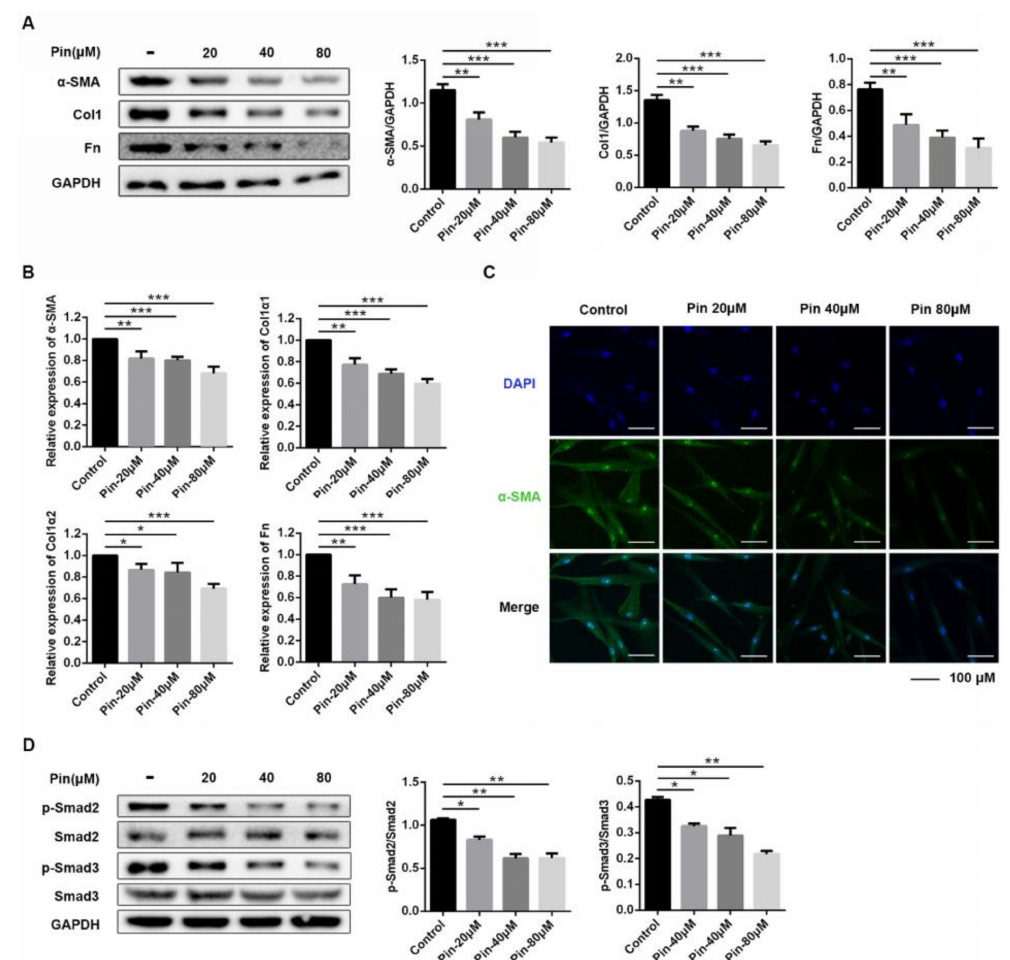
Figure 4. Pinocembrin reduces fibrosis-associated gene and protein expression in keloid fibroblasts. KFs were treated with pinocembrin (0, 20, 40, 80 µ M) for 24 h. ( A ) The protein levels of α -SMA, Col1a1, Col1a2, and Fn were analyzed by Western blot. ( B ) The mRNA levels of α -SMA, Col1a1, Col1a2, and Fn were analyzed by quantitative real-time